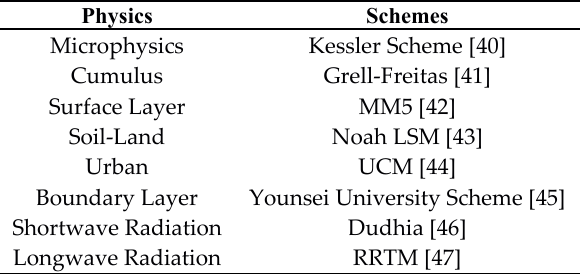
Table 1. Physical parametrizations used in this study.